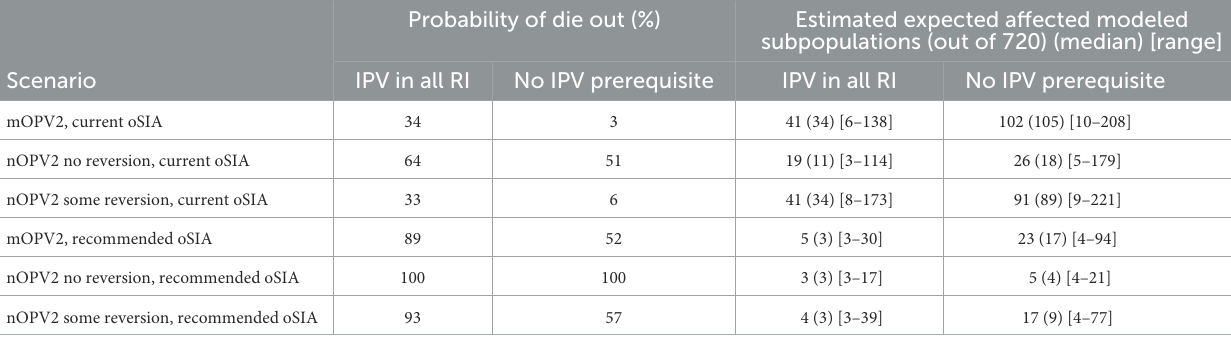
TABLE 4 Estimated probability of type 2 transmission die-out (defined as the number of iterations with no ongoing transmission as of December 31, 2026) and the expected value (median) [range] of affected modeled subpopulations out of 720 in 100 stochastic iterations for the scenarios